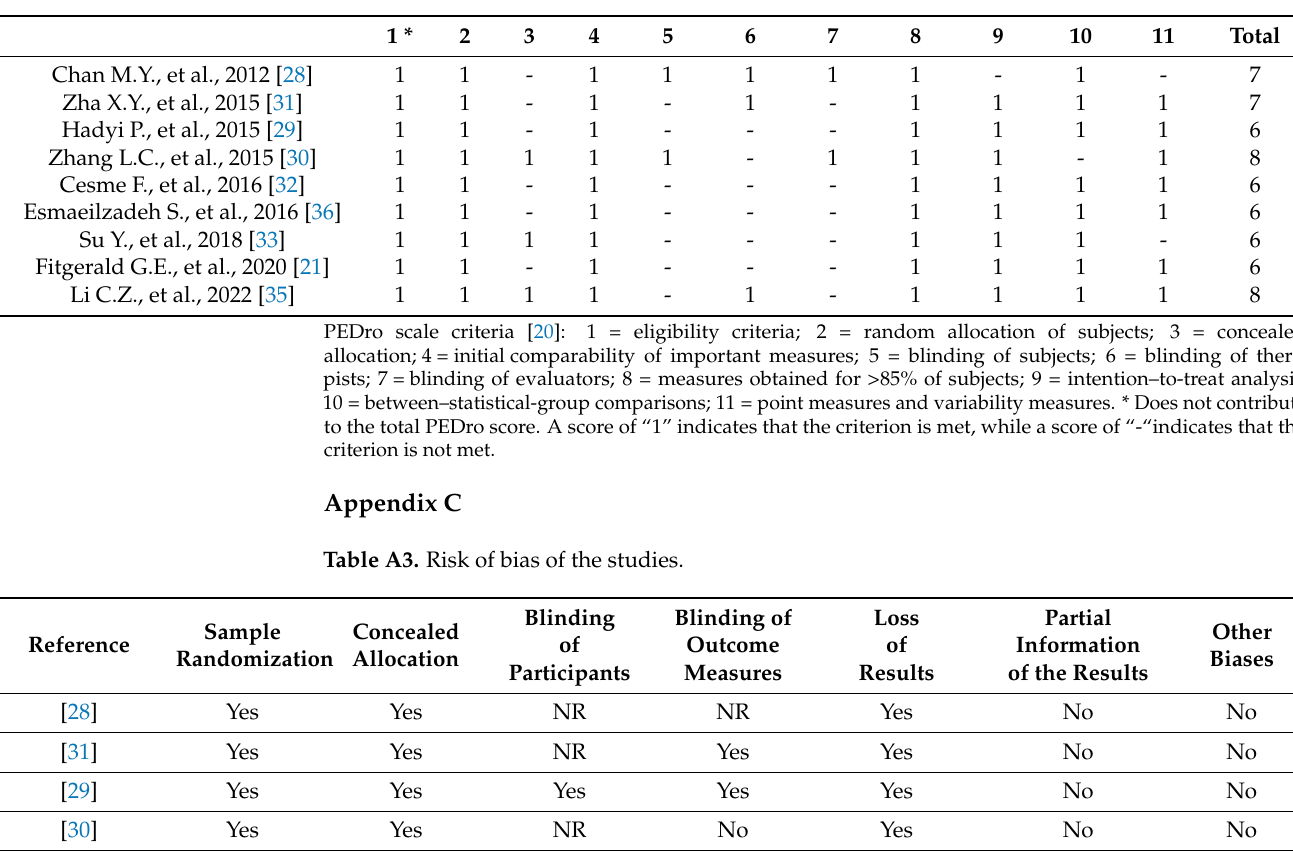
Table A2. Methodological review of the quality of included studies using the PEDro scale [20].